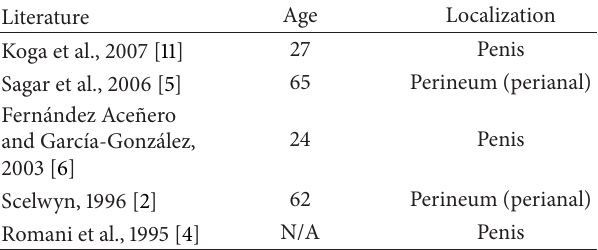
Table 1: Summary of median raphe cysts with ciliated epithelium.